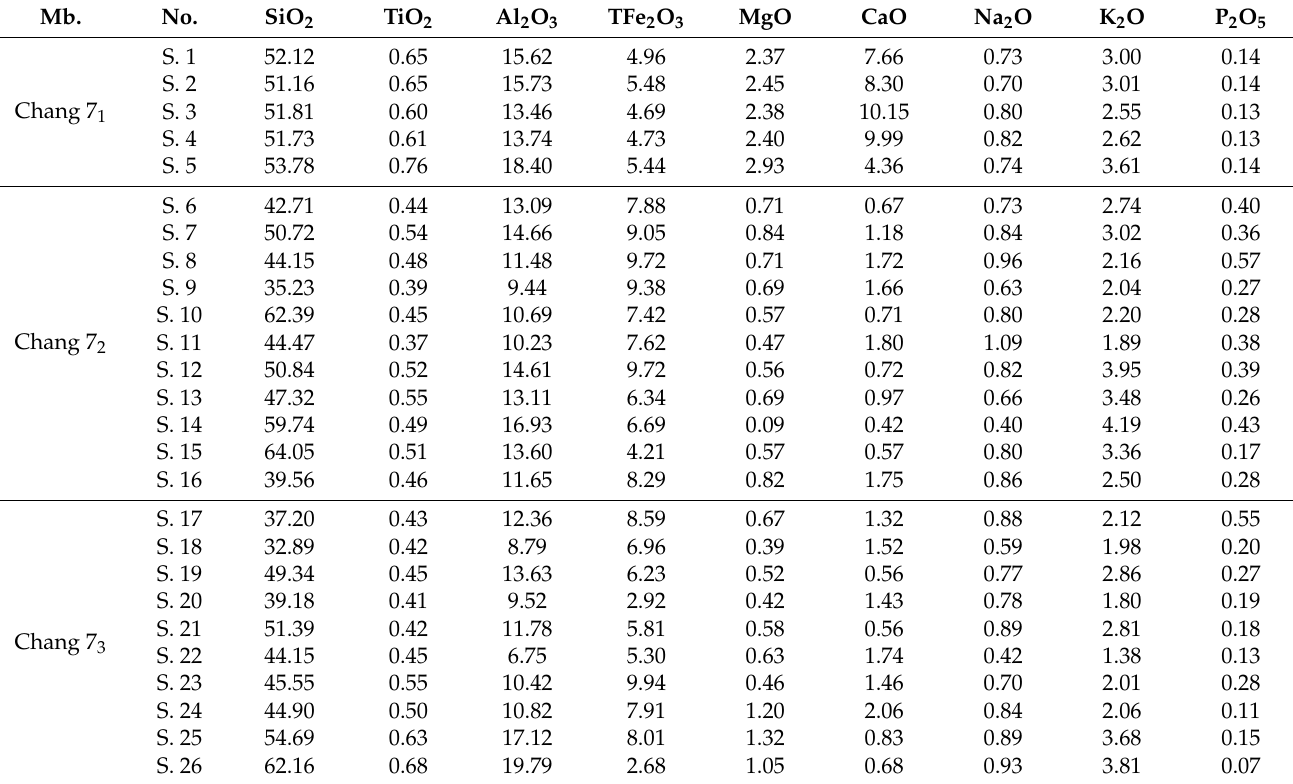
Table 1. Major element contents (wt.%) of the Chang 7